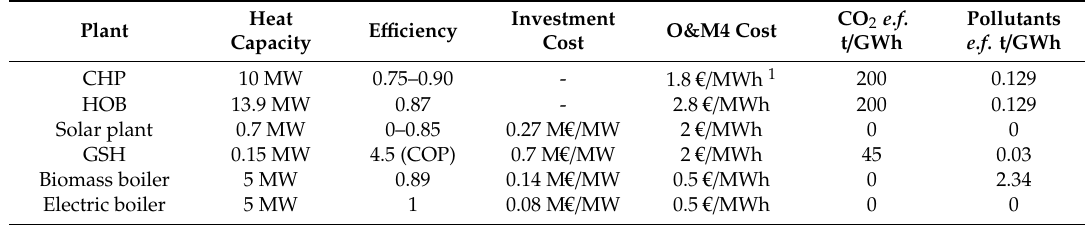
Table 4. Costs and properties of the components of the di ff erent alternatives considered in the analysis.